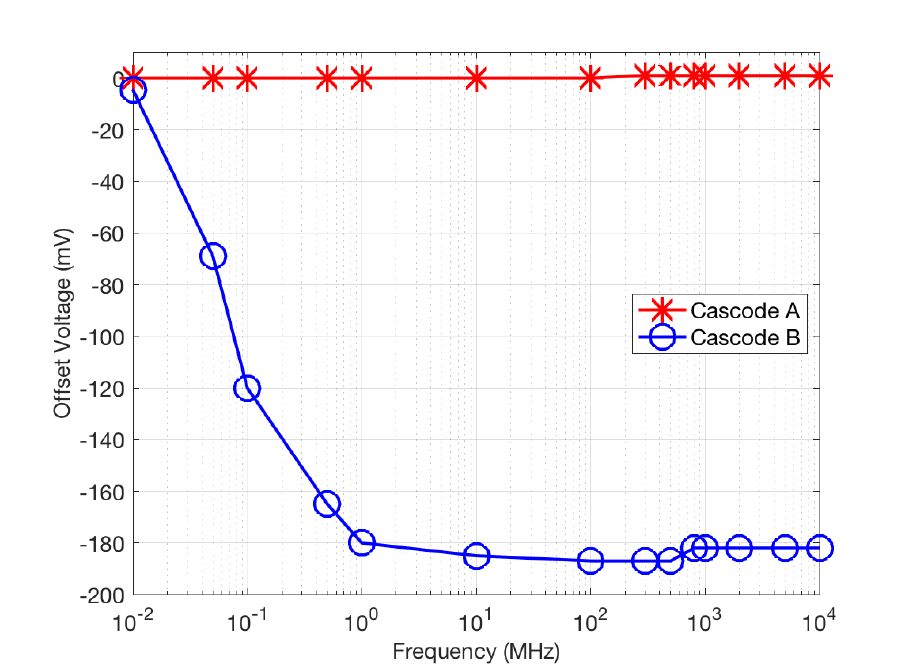
Figure 15. EMI induced offset in the cascode